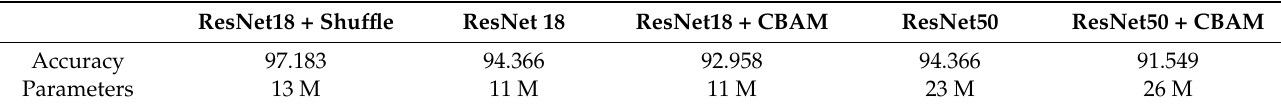
Table 1. Comparison of the diagnostic accuracy between the current network (ResNet18 + shuffle) and other available machine learning networks.